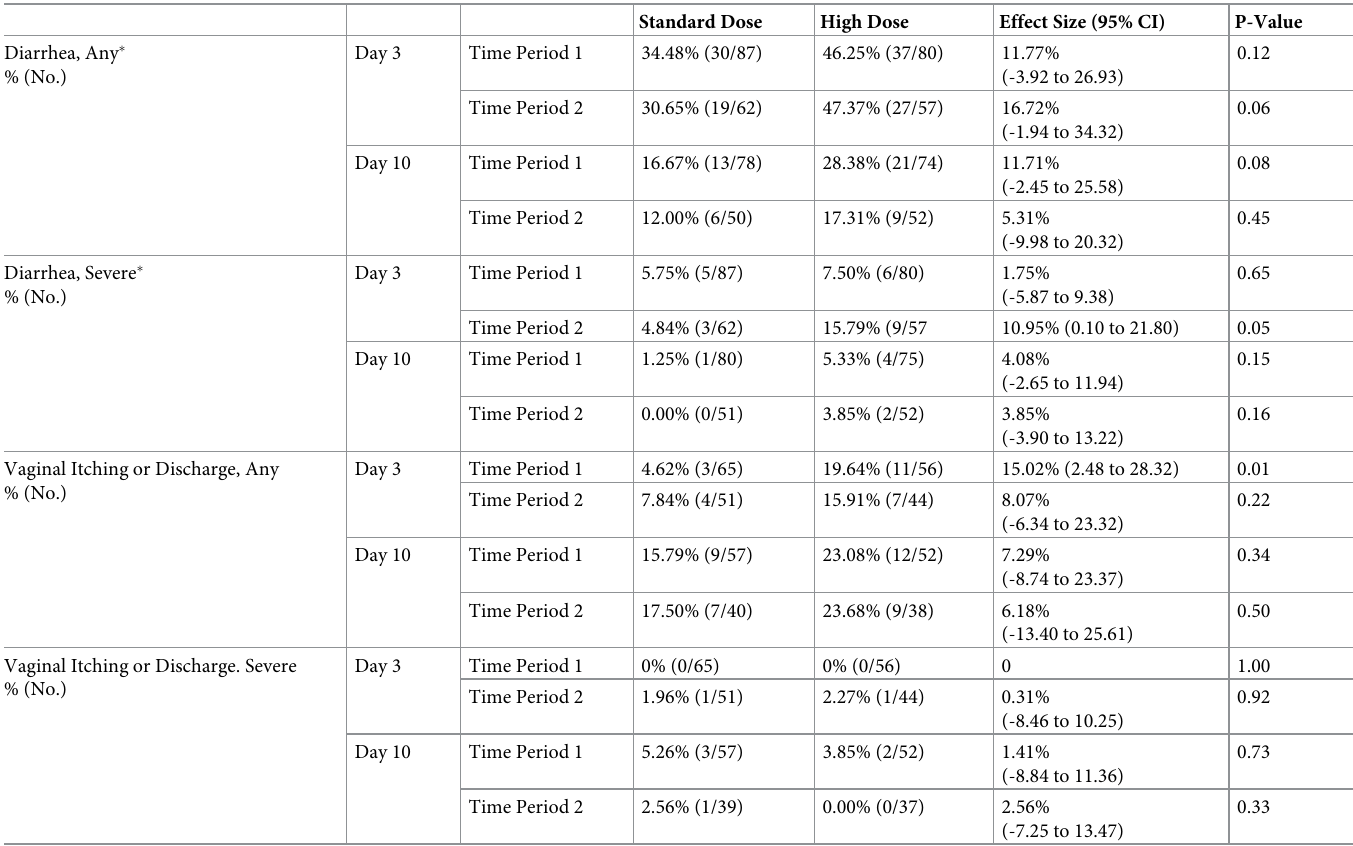
Table 5. Adverse effects by Time Period and Dose.